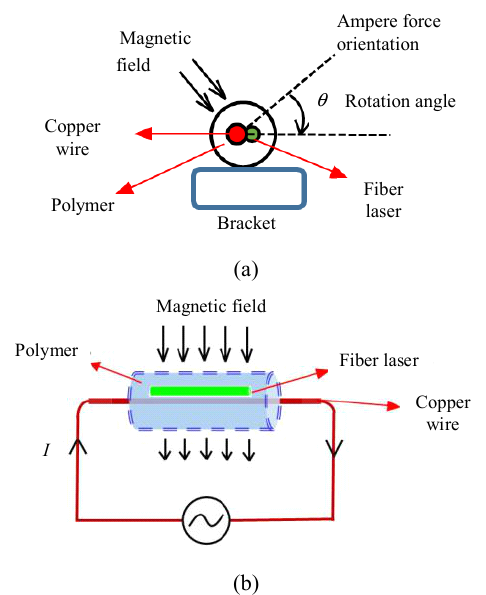
Fig. 1 Structure and principle of the sensor: (a) the cross-section of the fiber-optic magnetic field sensor and (b) working principle of the fiber-optic magnetic field